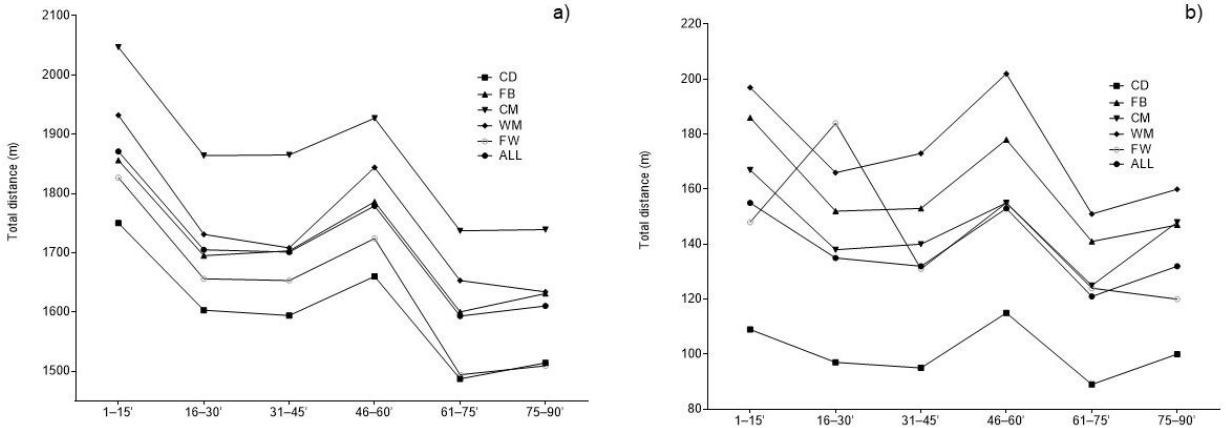
Figure 1. Total distance ( a ) and high-intensity running ( b ) across 15-min match periods (error bars omitted for clarity). Table 2. Descriptive statistics and differences in total distance covered and high-intensity running among 15-min match periods (data are given as mean ± SD).